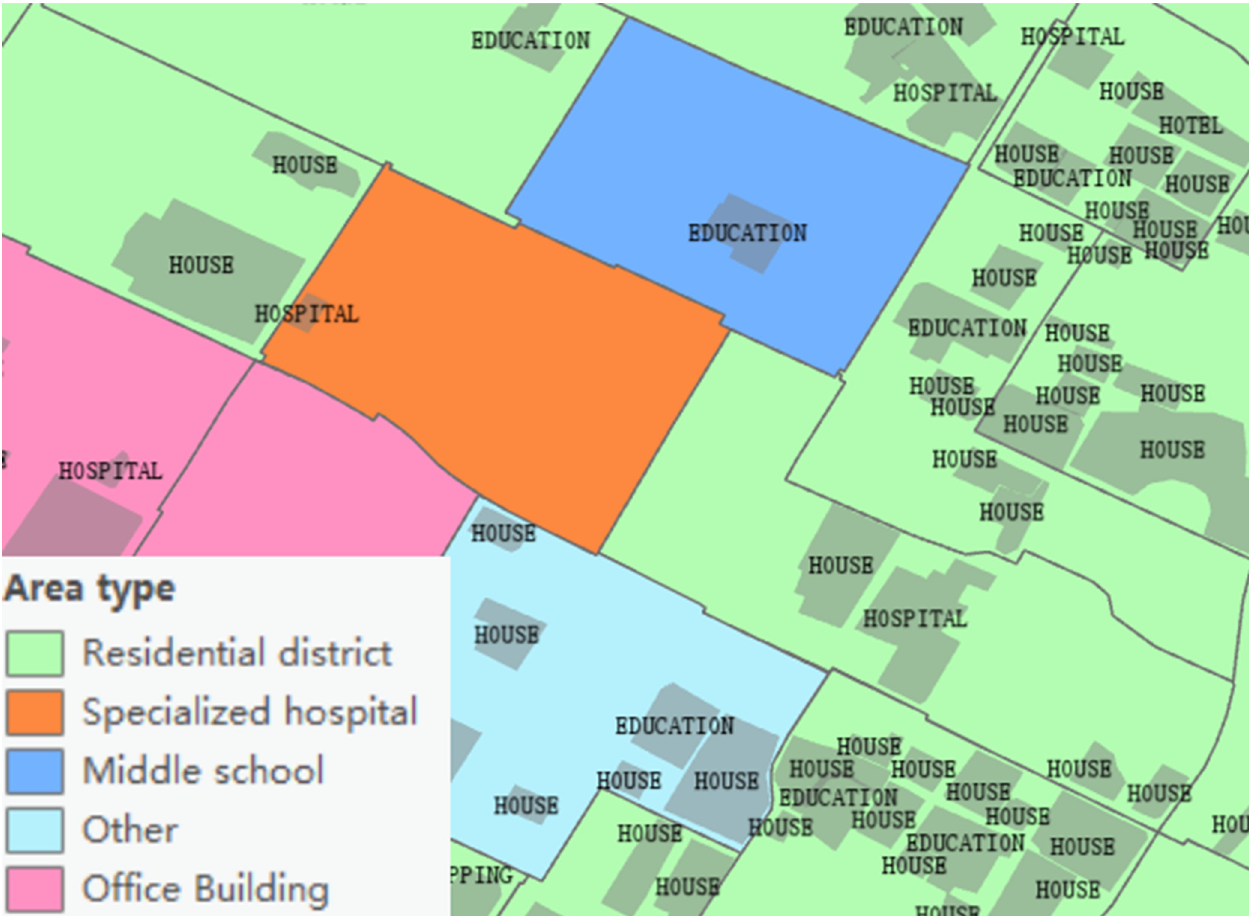
Figure 2. Illustration of the functional and connective characteristics of adjacent functional areas.